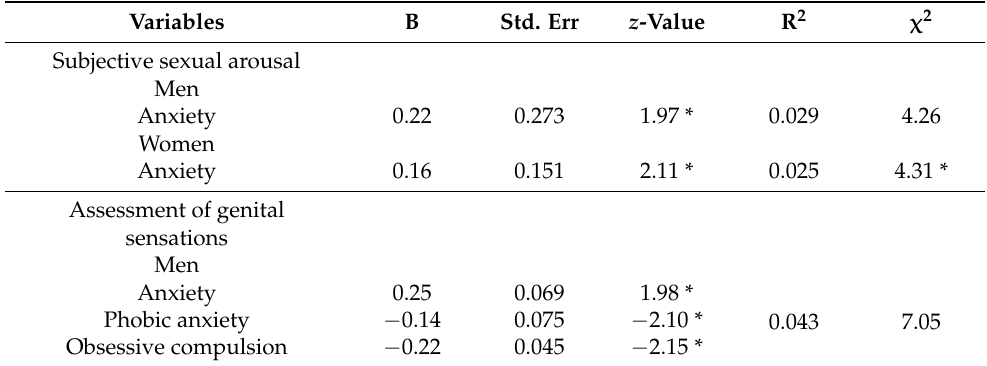
Table 7. Hierarchical linear regression analysis of subjective sexual arousal, and of the association of psychopathological